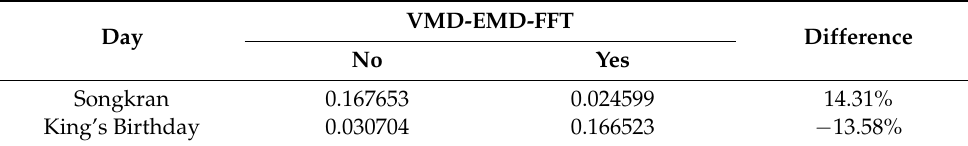
Table 13. Target days in which VMD-EMD-FFT has significant impacts on